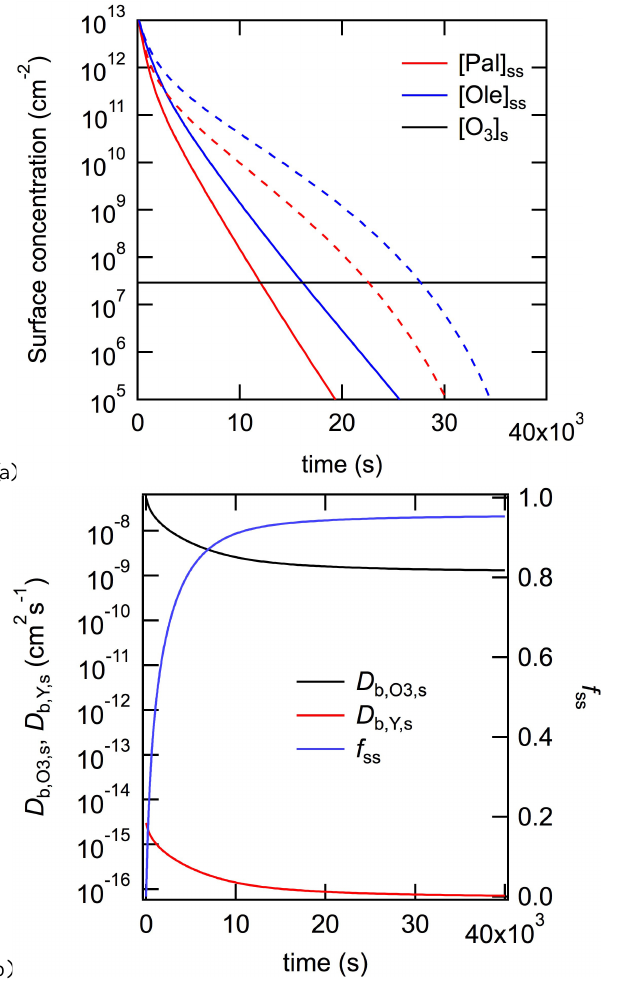
Fig. 4. Bulk diffusion coefficients of (a) ozone and (b) oleic acid as a function of time and depth in the 275nm-radius